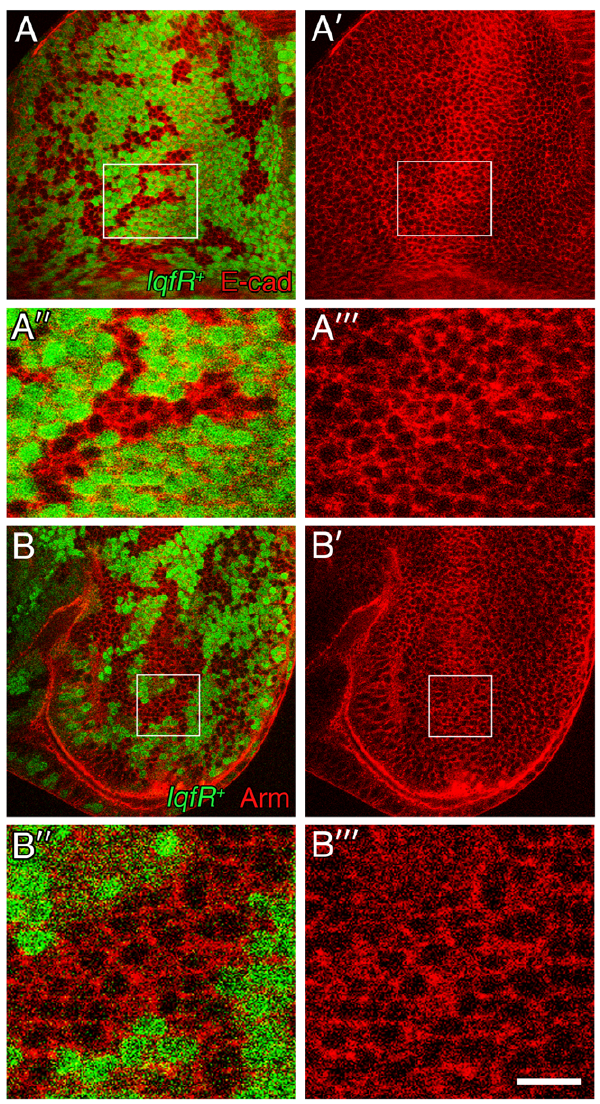
Figure 6. E-cadherin and Armadillo protein accumulation in lqfR - clones. (A,A 9 ) Confocal microscope images of an eye disc immunostained with E-cadherin antibodies (red). lqfR - clones are marked by the absence of GFP (green). (A 0 ,A 09 ) Enlargements of the boxed regions in A and A 9 . (B,B 9 ) Confocal microscope images of an eye disc immunostained with Armadillo antibodies (red). lqfR - clones are marked by the absence of GFP (green). The genotype for both experiments is ey-flp; FRT82B lqfR D 117 /FRT82B ubi-gfp . scale bar: , 40 m m in A,A 9 ,B,B 9 ; , 10 m m in A 0 , A 09 ,B 0 ,B 09 .